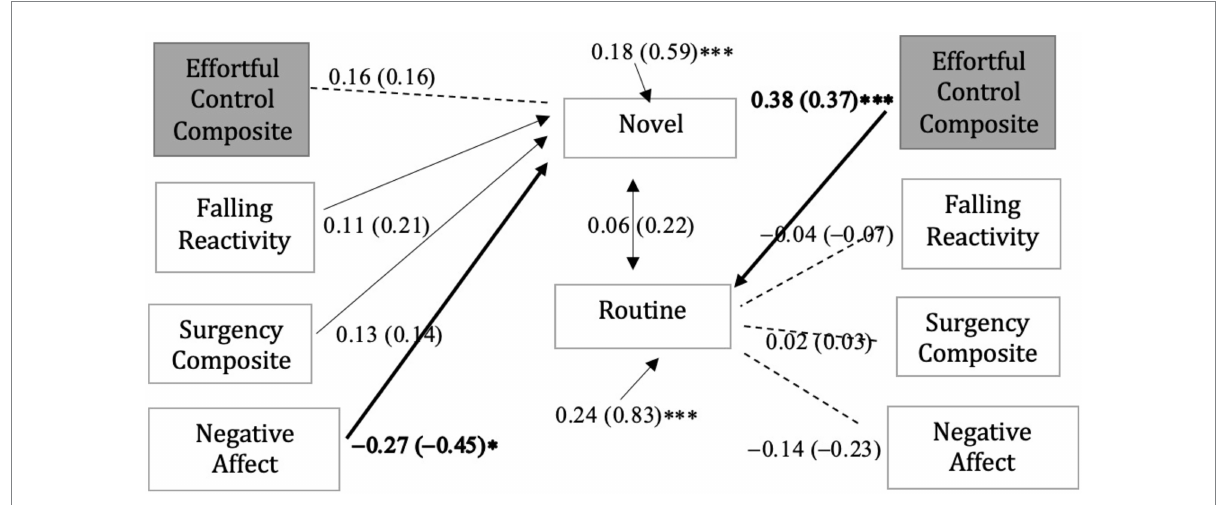
FIGURE 1 Structural model with traits measured by the Child Behavior Questionnaire. Each coefficient is followed by the standardized coefficient () in parentheses. The error variance indicates the amount of unexplained variance in Novel and Routine Adaptive Responsiveness. Solid lines indicate which relationships were hypothesized to be statistically significant, and bold arrows indicate the relationship was found to be statistically significant. No hypotheses were offered for relations indicated by the dotted lines. * p < 0.05, ** p < 0.01, *** p <